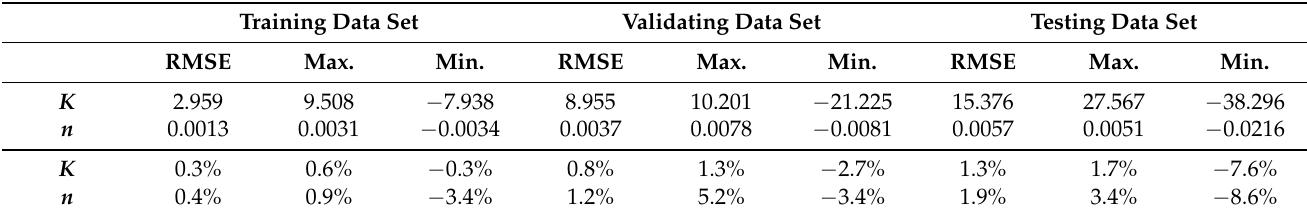
Figure 13. Neural network histogram of errors for ( a ) K output variable and ( b ) n output variable considering un-normalized values, all data sets and considering grouping each of the 91 cases error in 20 classes (i.e., bins). Table 4. Neural networks performance error for problem (a) in terms of RMSE, Max. and